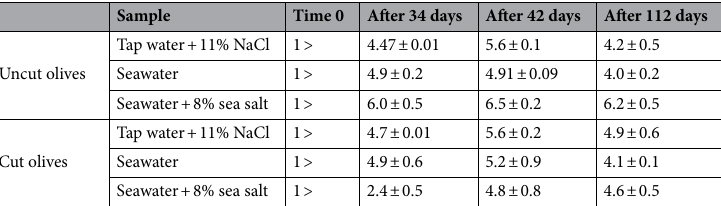
Table 2. Average yeast and mould counts along the fermentation in three different conditions. Values are mean log